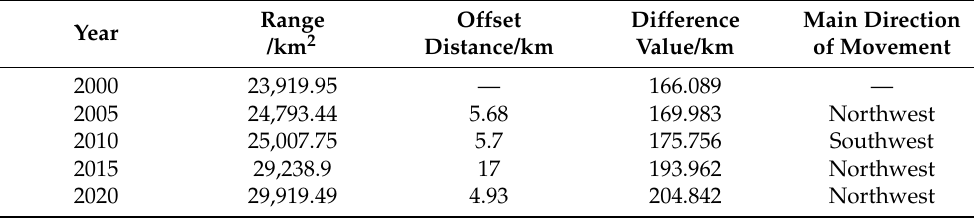
Figure 9. Ellipse of weighted mean and change in center of gravity. Table 3. Standard deviation ellipse data.